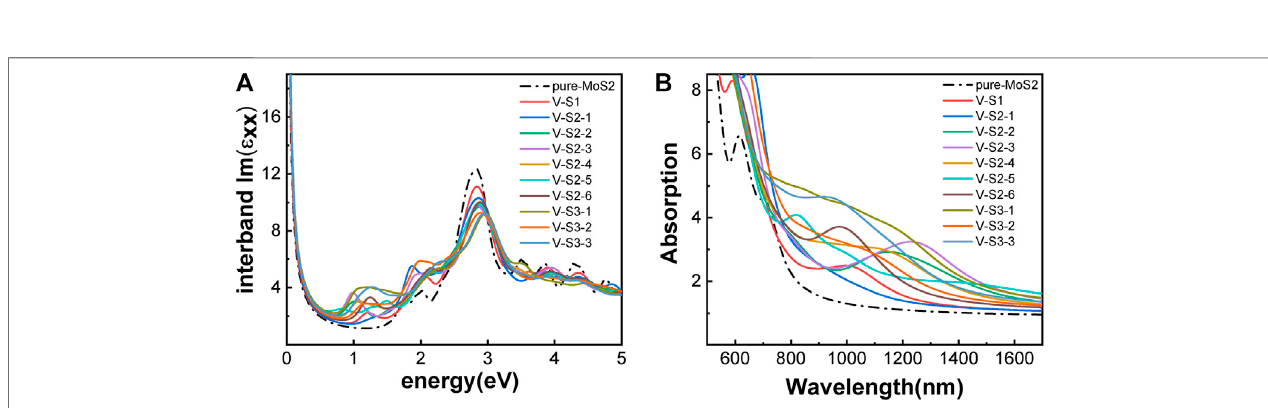
FIGURE 6 | Optical properties of monolayer 2H-MoS 2 with different S-vacancy defects: (A) the imaginary part of the dynamic dielectric function; (B) absorption spectra. The black dotted line is for pure monolayer 2H-MoS 2 . The labels in the legend refer to different vacancy structures as shown in Figure 4 .